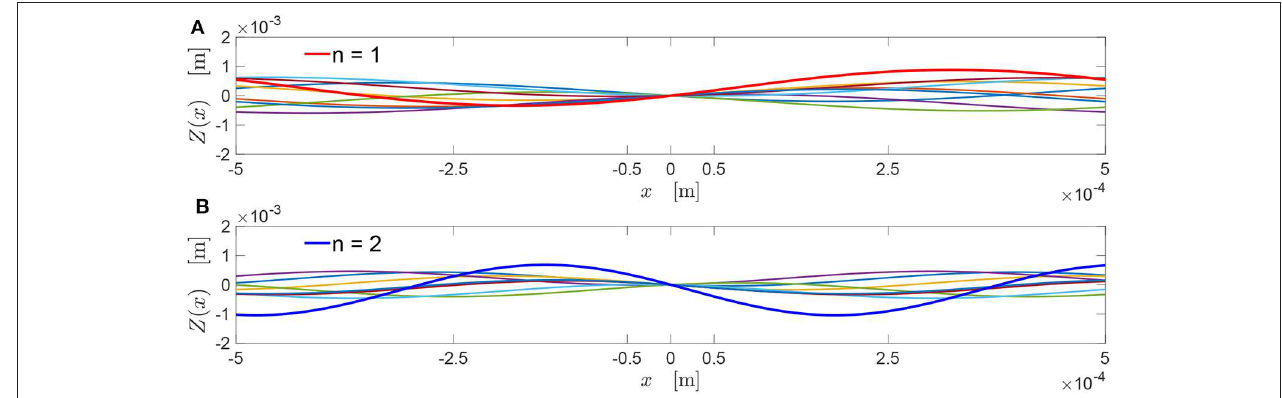
1. (B) The chromosome =